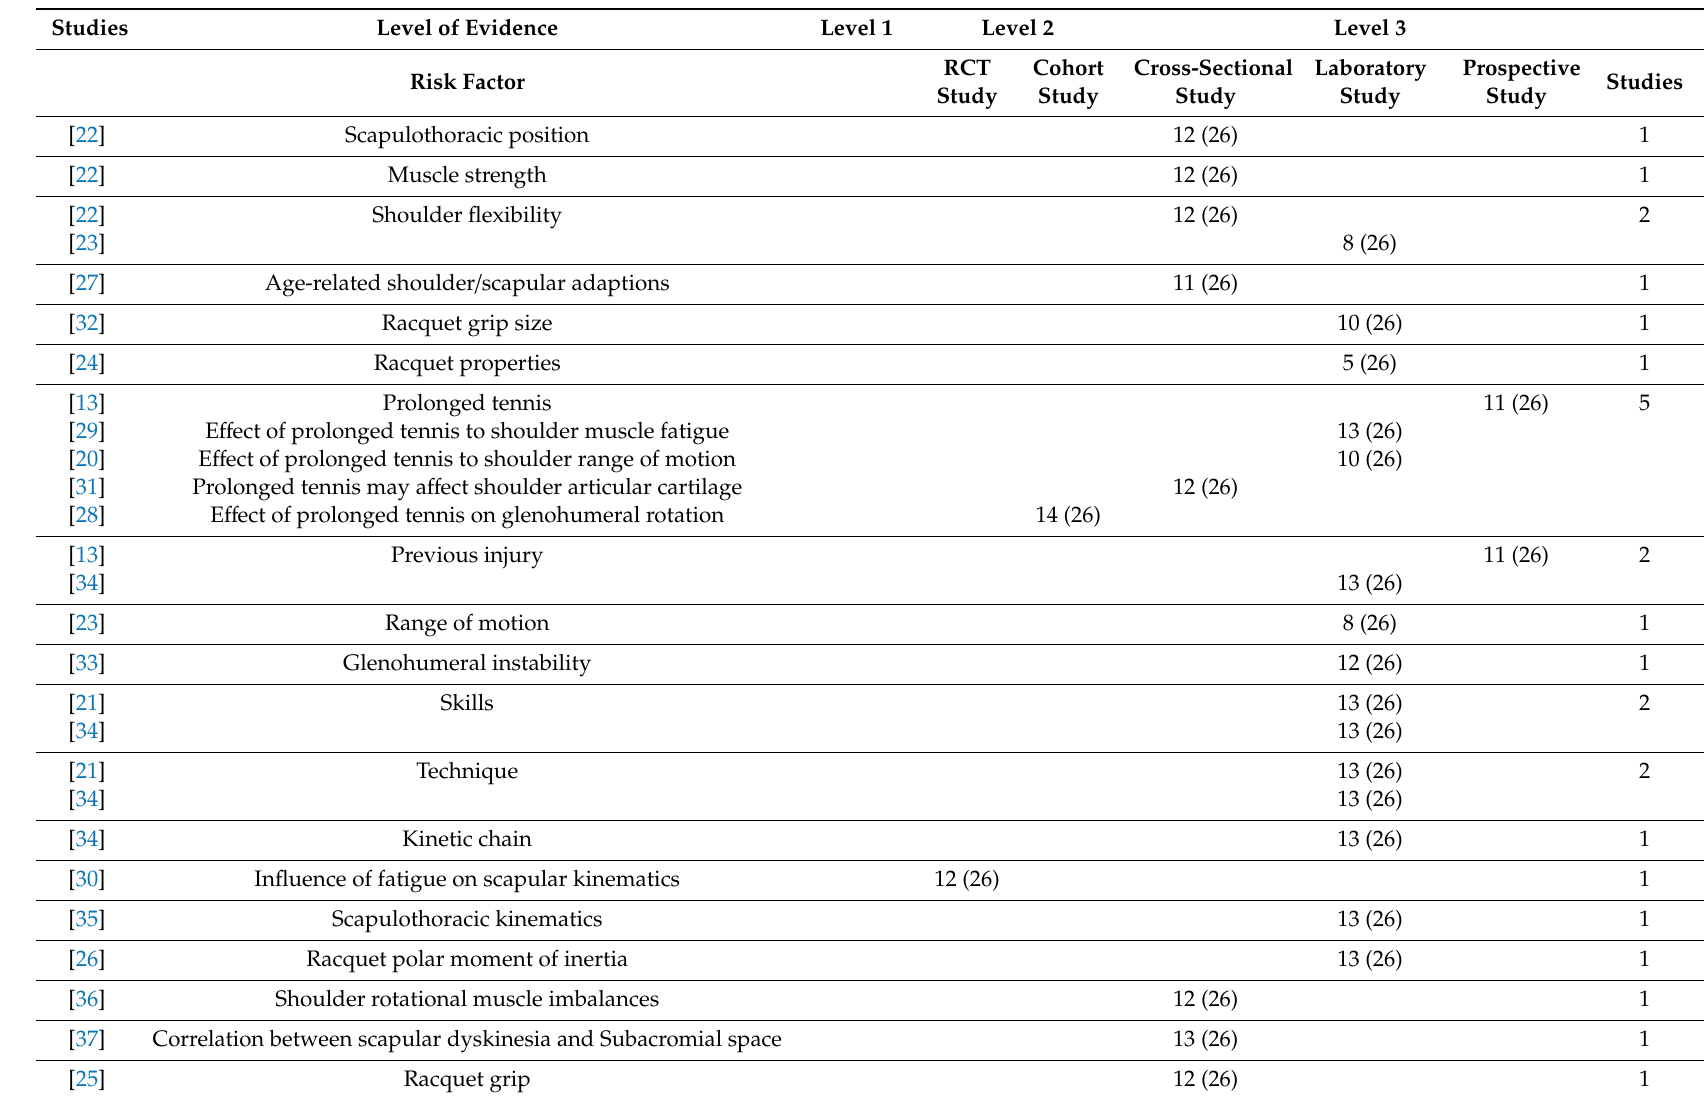
Table 7. Summary of injury risk factors by quantity, quality, and level of